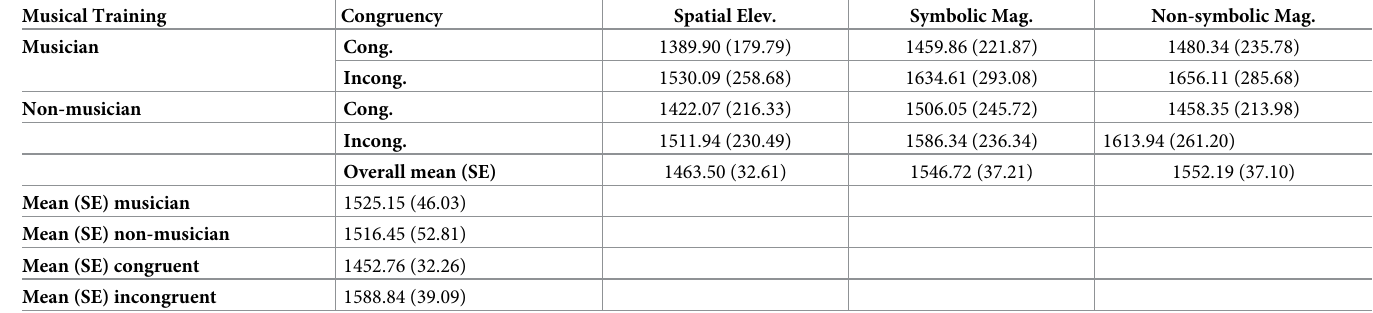
Table 1. Audiovisual category-wise mean response latencies (SD) in milliseconds for musicians and non-musicians in spatial elevation, non-symbolic magnitude, and symbolic magnitude categories, in both, congruent and incongruent conditions. At bottom, overall means (SE) for the audiovisual categories, musicians and non- musicians, and for congruent and incongruent